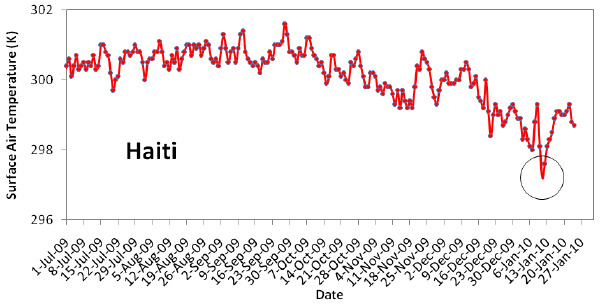
Figure 2a shows variation of surface temperature over the epiceneter during July 2009 to January 2010. A lowest surface temperature is observed over the epicenter one day prior to the main earthquake event.